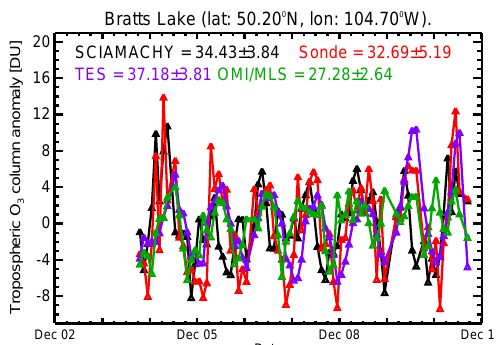
Figure 6. Monthly mean TOC anomaly in Dobson units (DU) from SCIAMACHY (black), ozonesondes (red), TES (violet) and OMI/MLS (green) over Bratt’s Lake (50.20 ◦ N, 104.70 ◦ W).